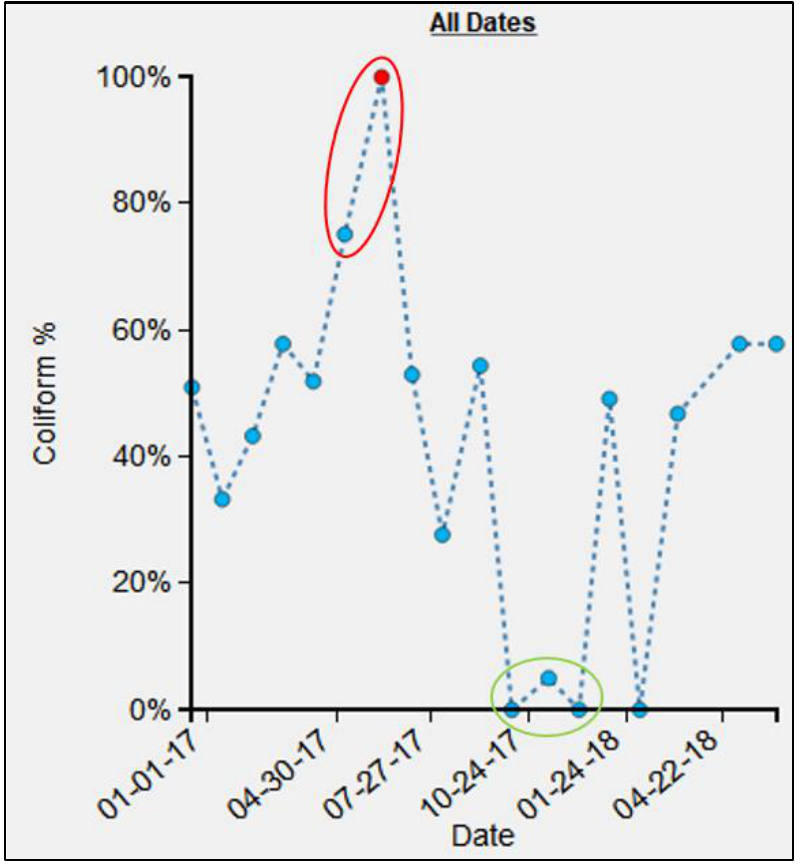
Figure 16. Epidemiological time-chart indicating FC count for P1. The red ellipse indicates consistently higher FC count values, whereas the green ellipse indicates consistently lower FC count value.